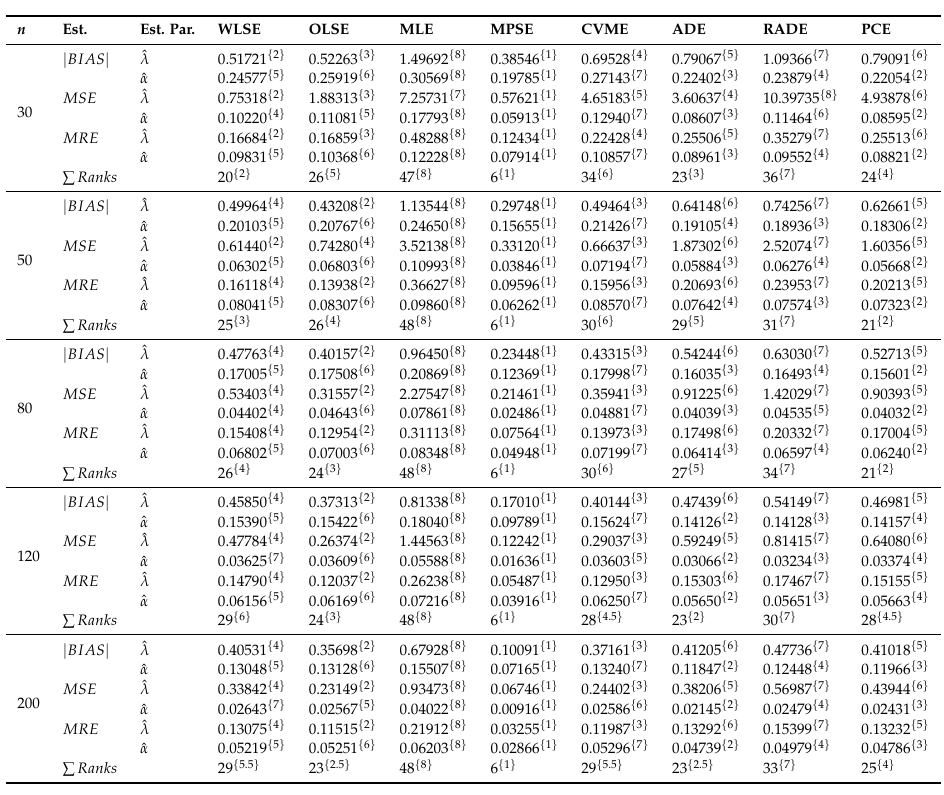
Table 7. Simulation results for φφφ = ( λ = 3.1, α = 2.5 ) (cid:124)